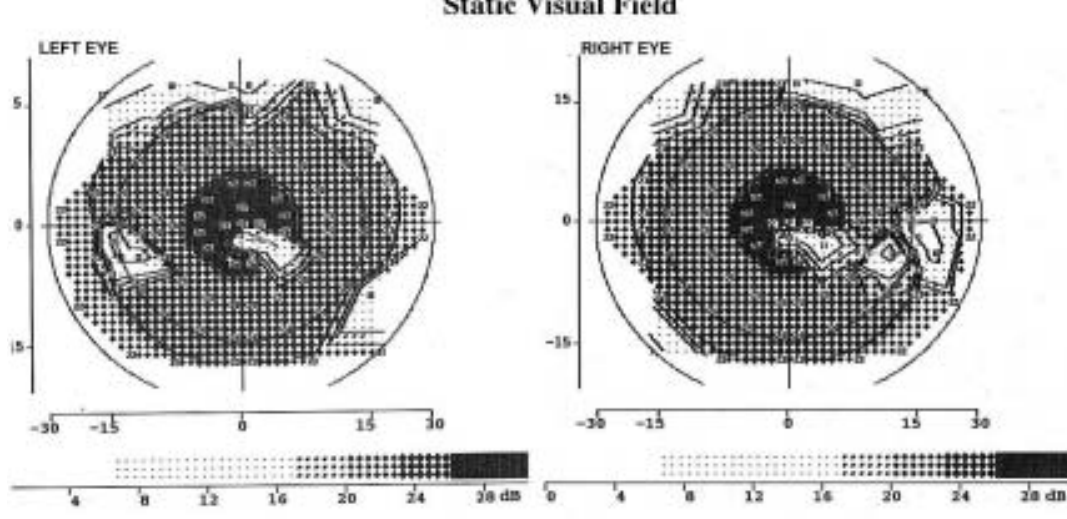
Fig. 2. Perimetric examination showed a small parafoveal scotoma in the right inferior